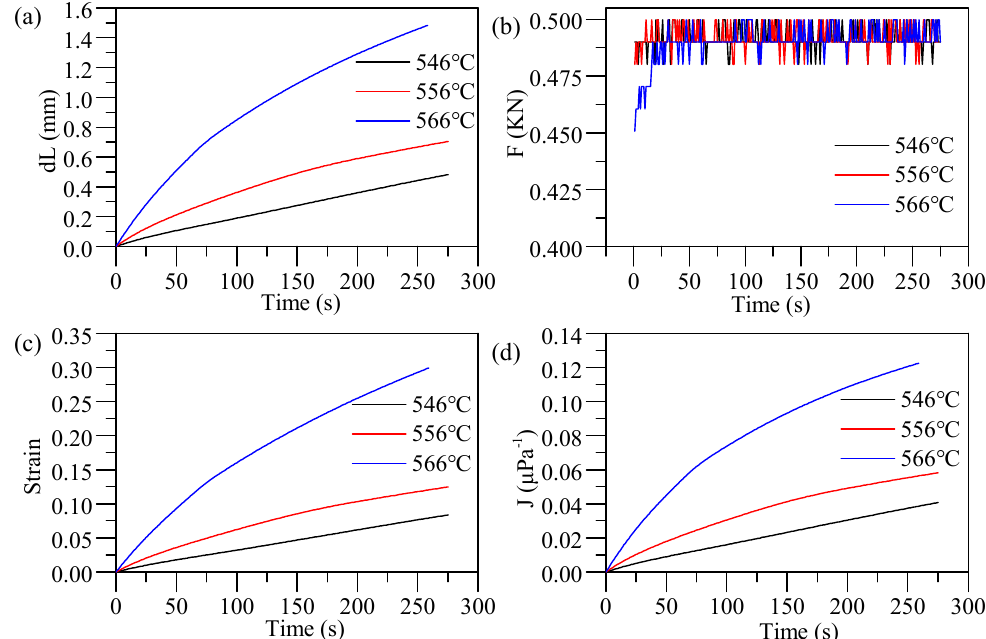
Figure 8. Calculated values for di ff erent temperatures: ( a ) thickness variations of the lens; ( b ) load;